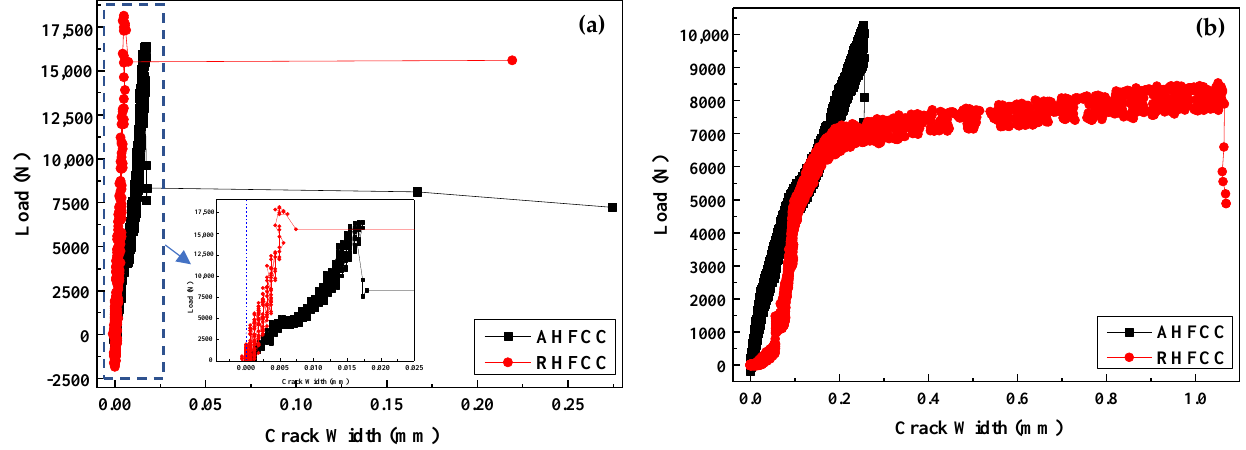
Figure 6. Splitting tensile test analysis: ( a ) load–crack width curve before healing, ( b ) load–crack width curve after healing. Table 2. Results of the splitting tensile test before and after